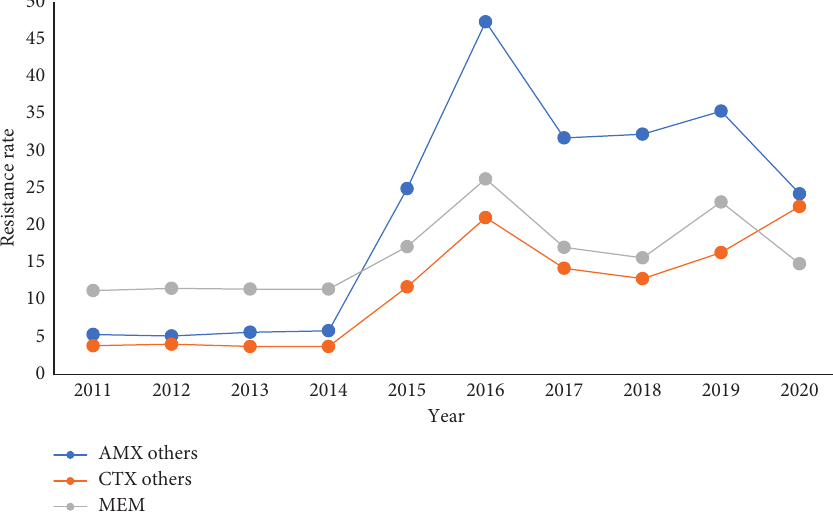
Figure 13: Changes in drug resistance of S. pneumoniae from 2011 to 2020 (%).